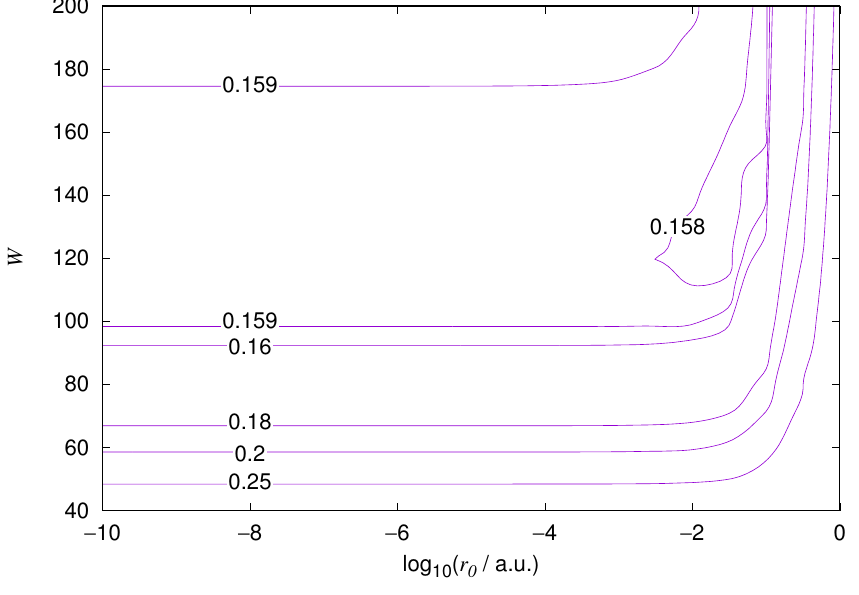
Figure 8. Relative error of the wavefunction value at the core radius for the 1s orbital of the ground state of the helium atom. Notations as in Figure